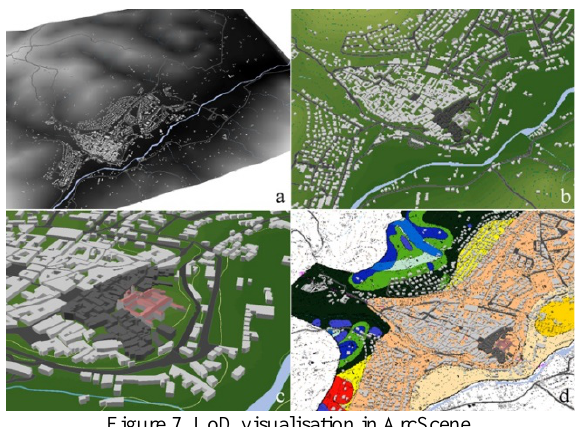
Figure 7. LoD visualisation in